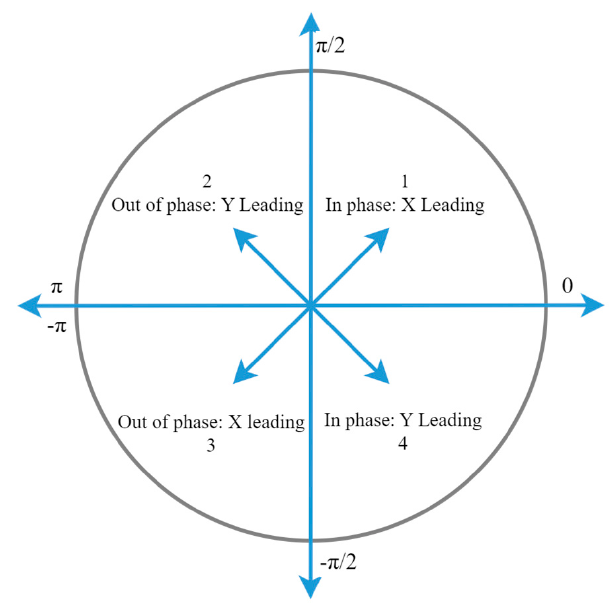
Figure 3. Phase differences and their Figure 3. Phase di ff erences and their interpretation.